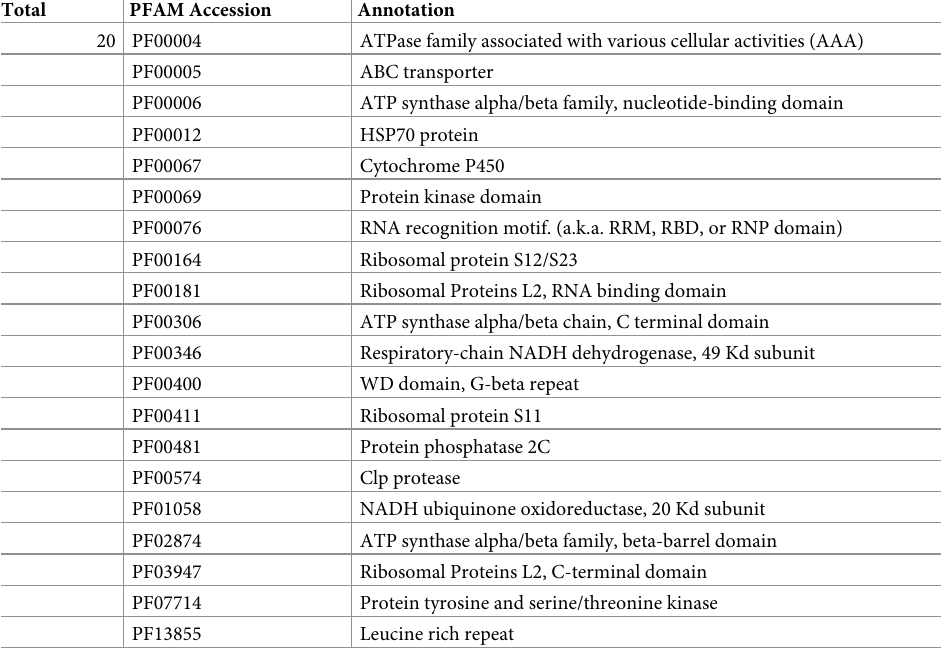
Alignment and comparative analysis for coding content and conserved sequence structure between GS and GR eccDNAs and the eccDNA replicon [25] identified a total of 162 GS eccDNA and 2,547 GR eccDNA with at matches at least 100 bp in length with a percent iden- tify of at least 95% [Fig 5]. A total of 7 and 11 eccDNA replicon genes were predicted in GS and GR eccDNA, respectively [S8 Table]. Predicted eccDNA replicon genes in GS eccDNA include PEARLI4, Heat shock (HSP70), no apical meristem (NAM), replication factor-A, ret- rotransposon, zinc finger, and suppressor of gene silencing [S8 Table]. GR predicted replicon Table 3. Gene elements shared by all GR eccDNA samples. Total PFAM Accession Annotation 20 PF00004 ATPase family associated with various cellular activities (AAA) PF00005